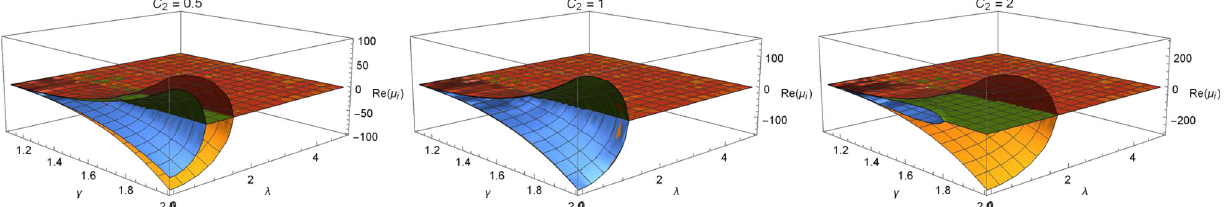
Fig. 15 Real parts of the μ i ’s corresponding to P 14 (λ) for some values of C 2 the solutions. The equilibrium points obtained by [67] are recovered as particular cases of the present model. In the (v) notation Kernel sgn the kernel indicates the interpretation sgn (Σ) of the point: M , C represent the Minkowski spacetime; K represents a Kasner solution; T corresponds to static solu- tions; SL ± corresponds to a flat FLRW space and static orbits depending on the parameter γ . H is associated with a change of causality of the homothetic vector field. The following results were